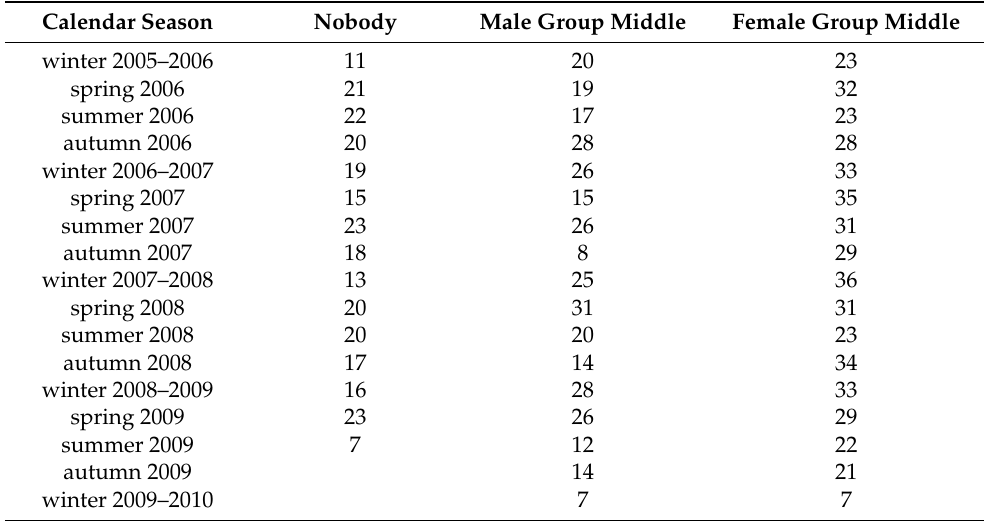
Table 1. The number of the medical events under study in the different seasons in the observing time